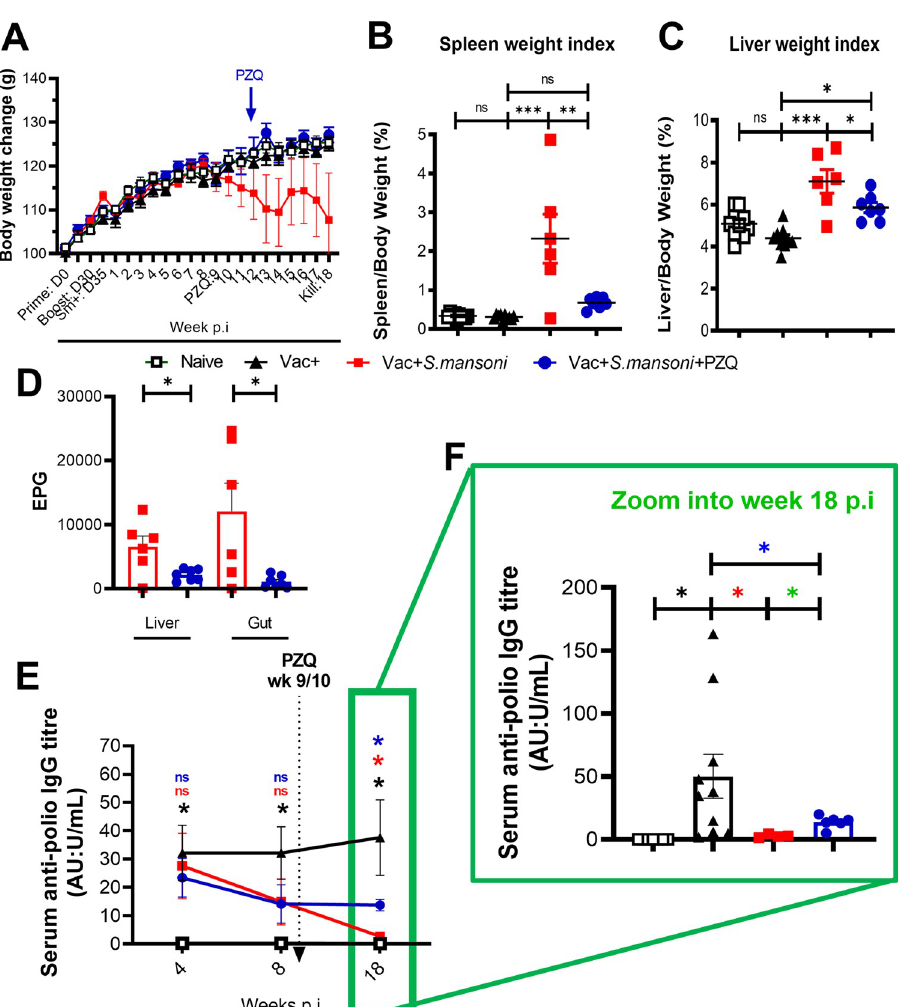
Fig 2. Body weights, organ weights and histopathological profile of chronic S . mansoni infected mice post Inactivated Poliovirus Vaccine (IPV) immunisation and after treatment with PZQ. (A) Body weight changes over time. Note a drastic weight drop in the Vac+ Sm+ group that is rescued in the Vac+Sm+PZQ+ group. (B) Spleen/body weight index at week 18 p.i (C) Liver/body weight index at week 18 p.i (D) Number of eggs per gram of liver or gut at 18 week p.i (E) Serum anti-polio IgG titre kinetics response to poliovirus vaccination in schistosomiasis-infected mice for all mice at week 4, 8 and 18 p.i (F) Anti-poliovirus IgG titres at week 18 p.i Data are expressed as mean ± S.E.M and representative of 2 independent experiments (n = 4–10 mice per group in each experiment); Data was analysed by Shapiro-Wilk test. Data was analysed by one way ANOVA followed by the Bonferroni’s multiple comparisons test (B-C); two tailed Student’s t test for unequal variances (D); two-way ANOVA followed by FDR corrected multiple comparisons with Vac+ group as a statistical reference with (E-F) and colour codes of black (comparison Vac+ vs Naive), red (comparison vac+ vs vac+Sm+), blue (comparison vac+ vs vac+sm+PZQ+) and green (vac+Sm+ vs Vac +Sm+PZQ+); ns, p > 0.05; � p < 0.05, �� p < 0.001, ��� p < 0.0001; Vac, hexavalent (DTPa-hepB-IPV-Hib) vaccine; Vac +, vaccinated; Sm, S mansoni ; Sm+, infected with S . mansoni; PZQ, praziquantel; PZQ+, treated with PZQ;p.i, post S . mansoni